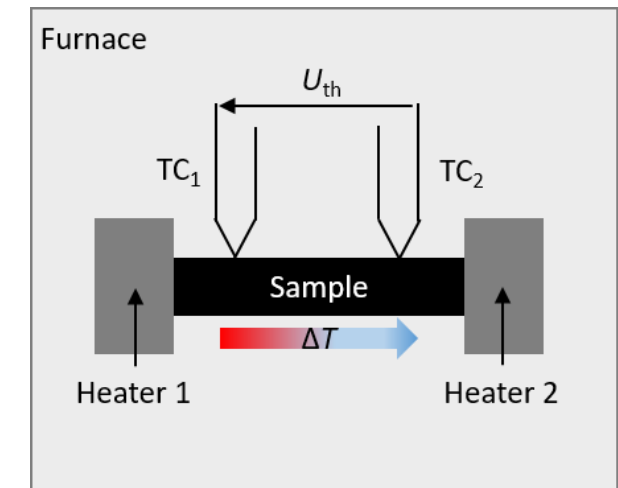
Figure 1. Representation of a typical arrangement to determine the Seebeck coefficient with a sample clamped between two heaters and two thermocouples (TC 1 and TC 2 ) to measure the contact point temperature and the thermovoltage U th . Usually, such setups are installed in furnaces, if the Seebeck coefficient of the sample is to be determined at high